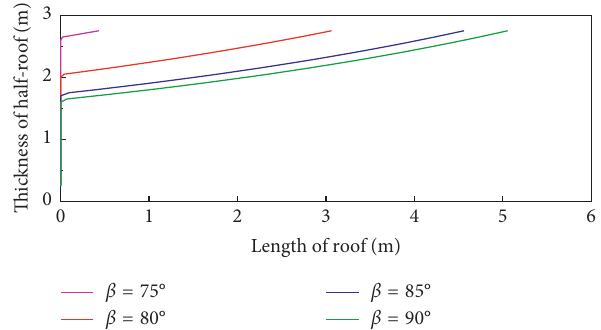
Figure 11: Effect of different crack inclinations on the boundary of crack-affected area.